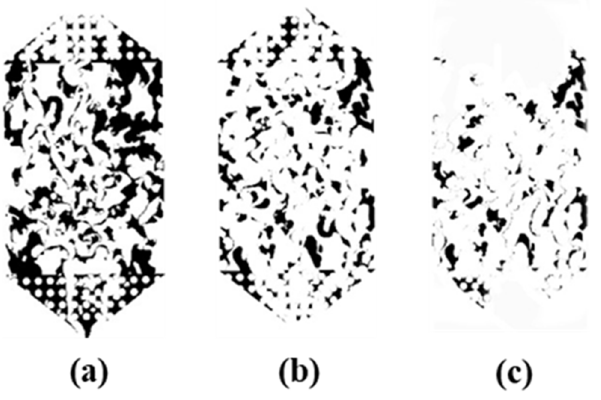
Figure 13. Binary images of the residual fracturing fluid (1.2 wt%) after flowback ( a ) 0.3 MPa gas drive, ( b ) 0.4 MPa gas drive, ( c ) 0.5 MPa gas drive.